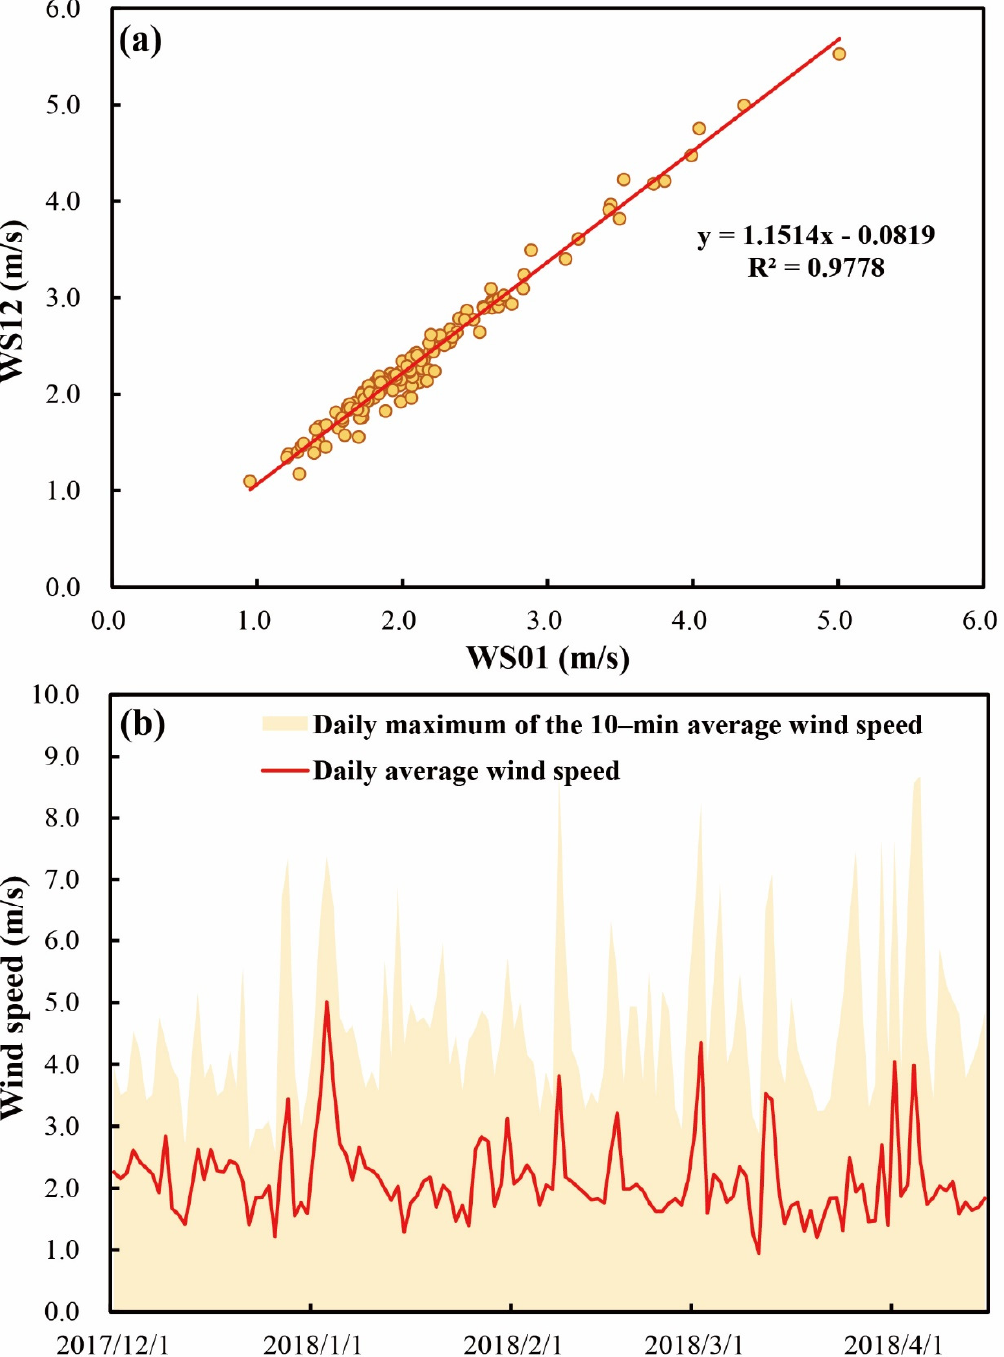
Figure 3. The relationship between daily average wind speed for height 0~1 m (WS01) and 1~2 m (WS12) ( a ), and changes in daily average WS01 and the daily maximum of the 10-min average wind speed from 1 December 2017 to 15 April 2018 ( b ).